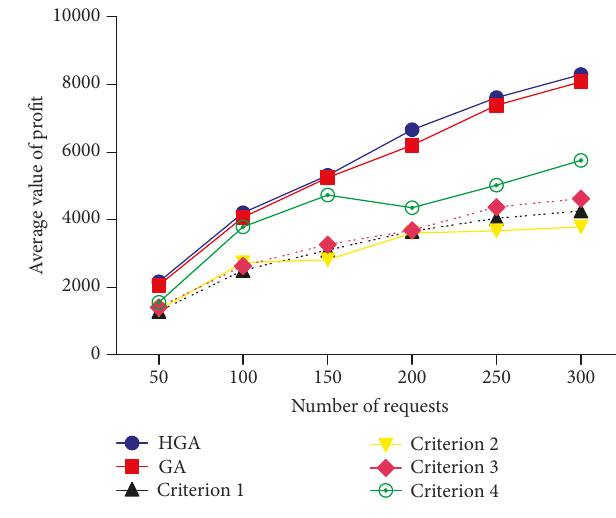
Figure 4: Pro fi t